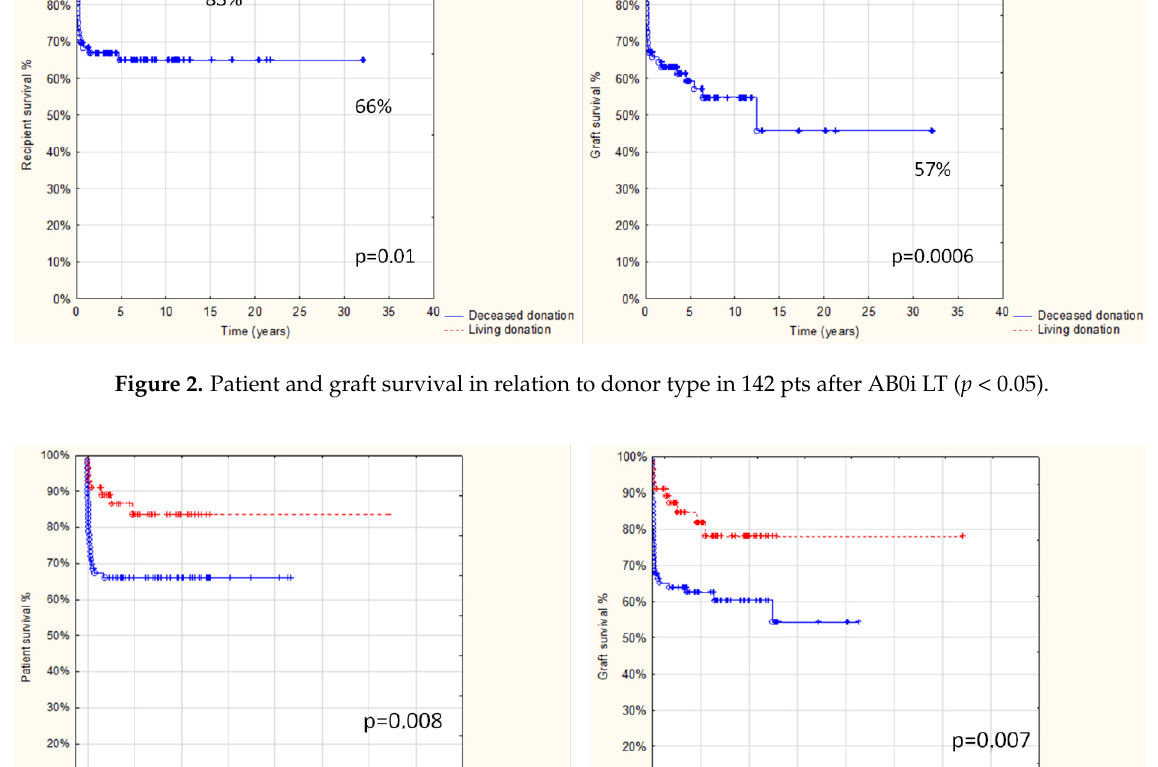
Figure 1. Overall AB0i LT patient and graft survival (142 pts after AB0i LT; 1986–2018).